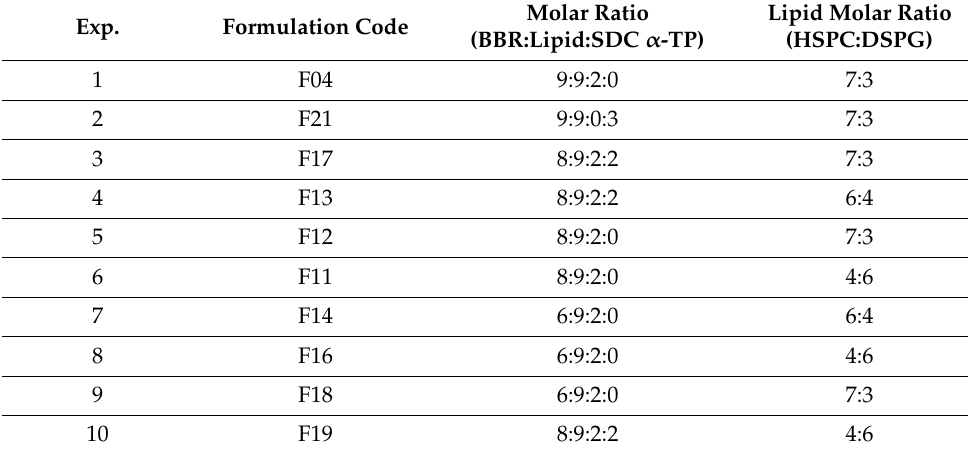
Table 2. The compositions of the berberine-loaded liposomes. Key: berberine (BBR), sodium deoxy- cholate (SDC), alpha-tocopherol ( α -TP), phosphatidyl choline (HSPC) and distearoyl phosphatidyl glycerol (DSPG). Exp. Formulation